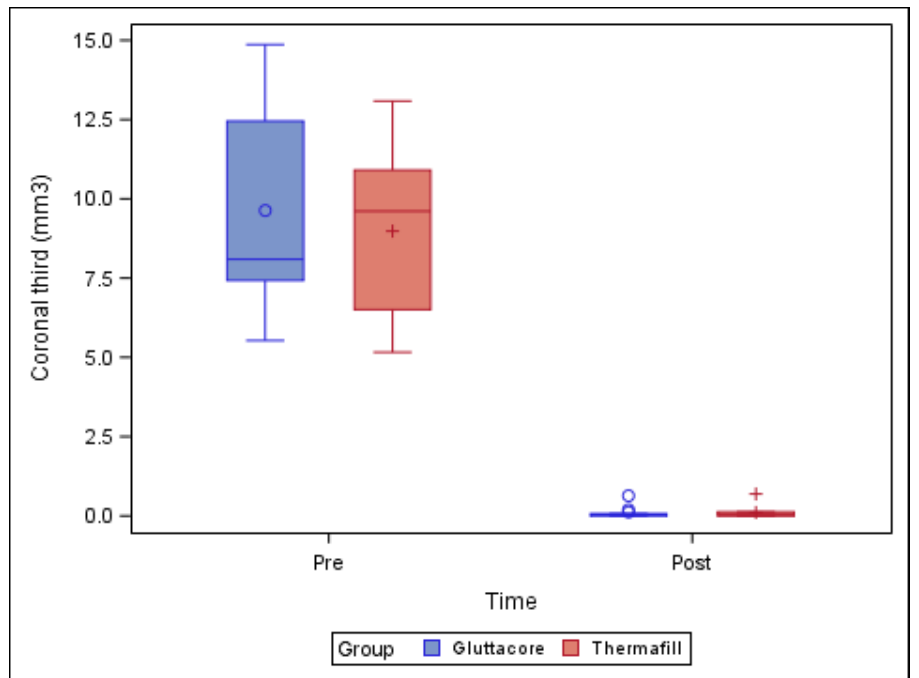
Figure 2. Box plot of the pre-operative root canal filling material volume (mm 3 ) and the remaining post-operative root canal filling material volume (mm 3 ) at the coronal third of the straight root canal systems, regarding the root canal filling material systems.